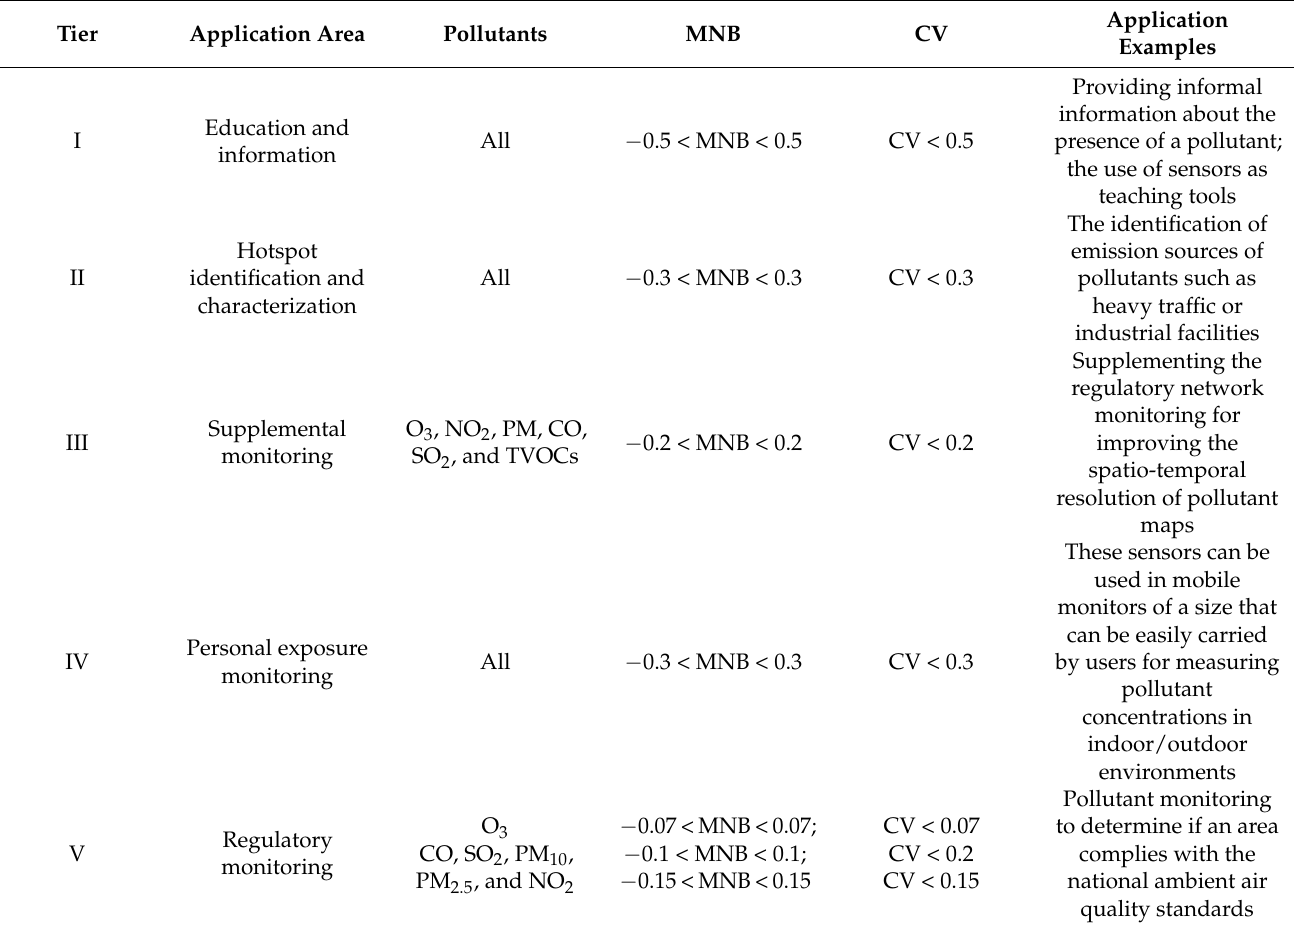
Table 1. Classification of possible uses, or application areas, for LCSs/LCMs proposed in EPA